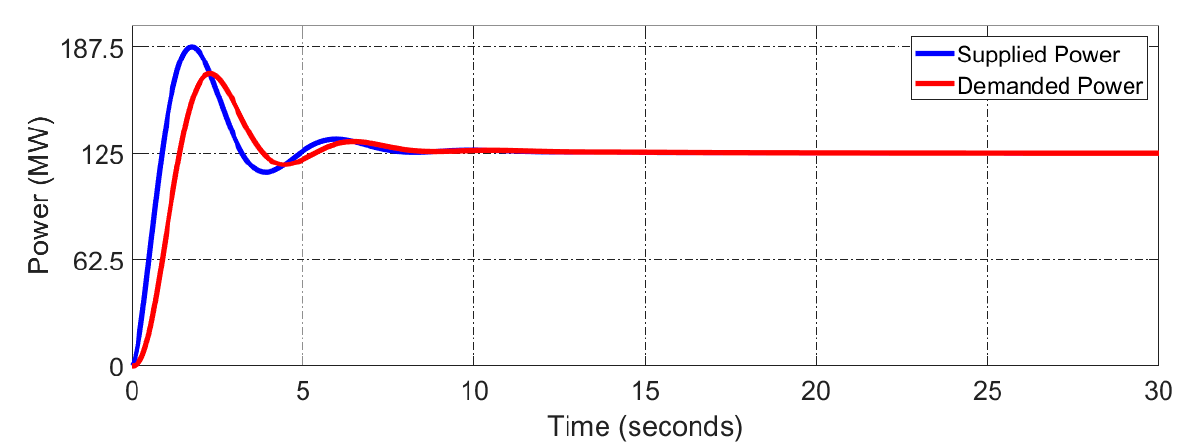
Figure 13. Step change load from 0% to 50% for a single-area PSN; ( a ) frequency, ( b ) power.